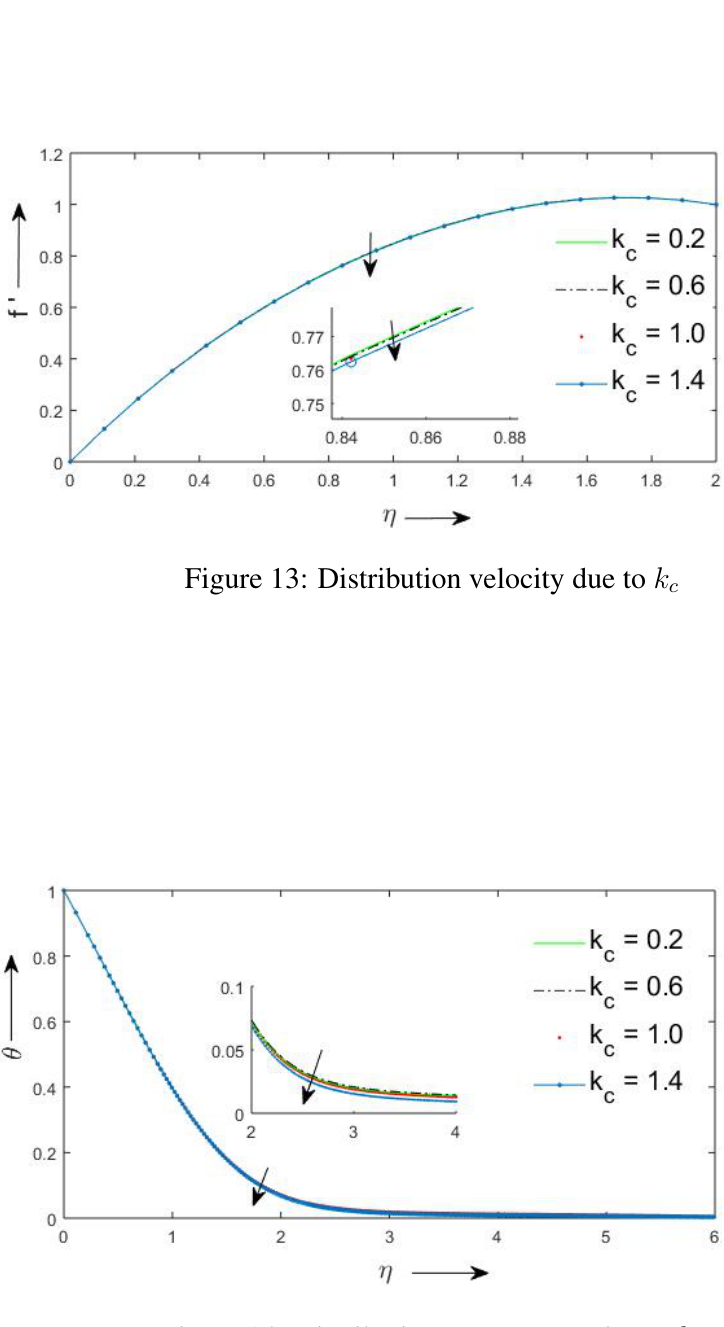
Figure 14: Distribution temperature due to k